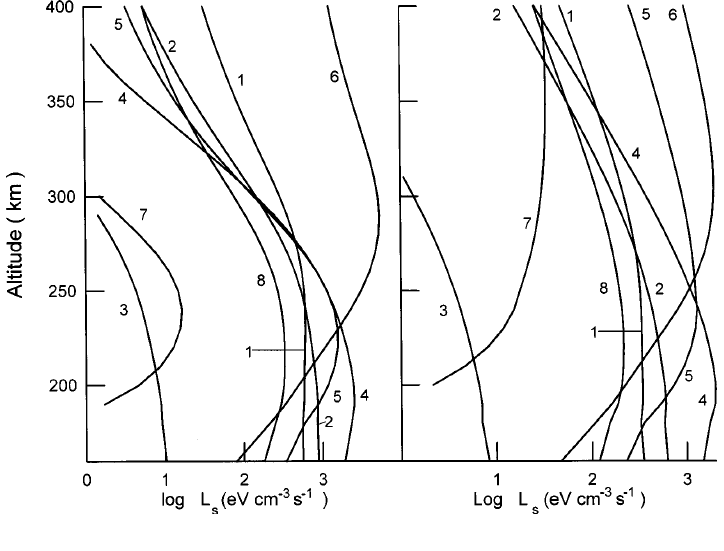
Fig. 3. Computed altitude profiles of electron cooling rates L s at 12.00 LT on 7 April, 1990, ( left panel ) and 9 April, 1990, ( right panel ). Line 1 gives the cooling due to fine structure excitation of atomic oxygen. The cooling rates by rotational excitation of N 2 and O 2 are shown by curves 2 and 3 . The cooling rates by vibrational excitation of O 2 and N 2 are shown by curves 4 and 5 . Line 6 shows the cooling due to Coulomb collisions electrons with ions and line 7 represents the electron cooling rate in collision of O (cid:133) 3 P (cid:134) with thermal electrons with the O (cid:133) 1 D (cid:134) formation. The total elastic cooling rate by elastic collisions of electrons with N 2 , O 2 , O, He, and H is shown by curve